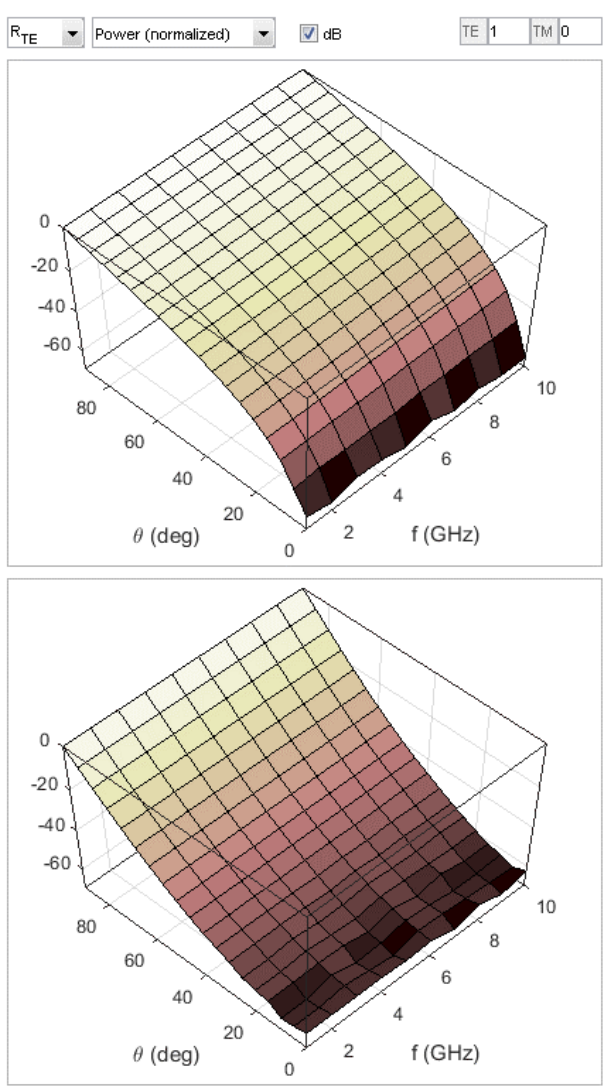
Figure 5: Reflectance of TE-polarized wave from perfect conductor covered with isotropic (top) and anisotropic (bottom) perfectly matched layers against frequency and incidence